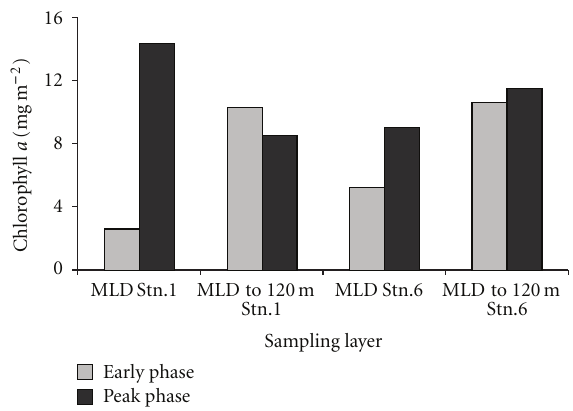
Figure 5: Integrated chlorophyll a (mgm − 2 ) concentration during early and peak phases of summer monsoon.